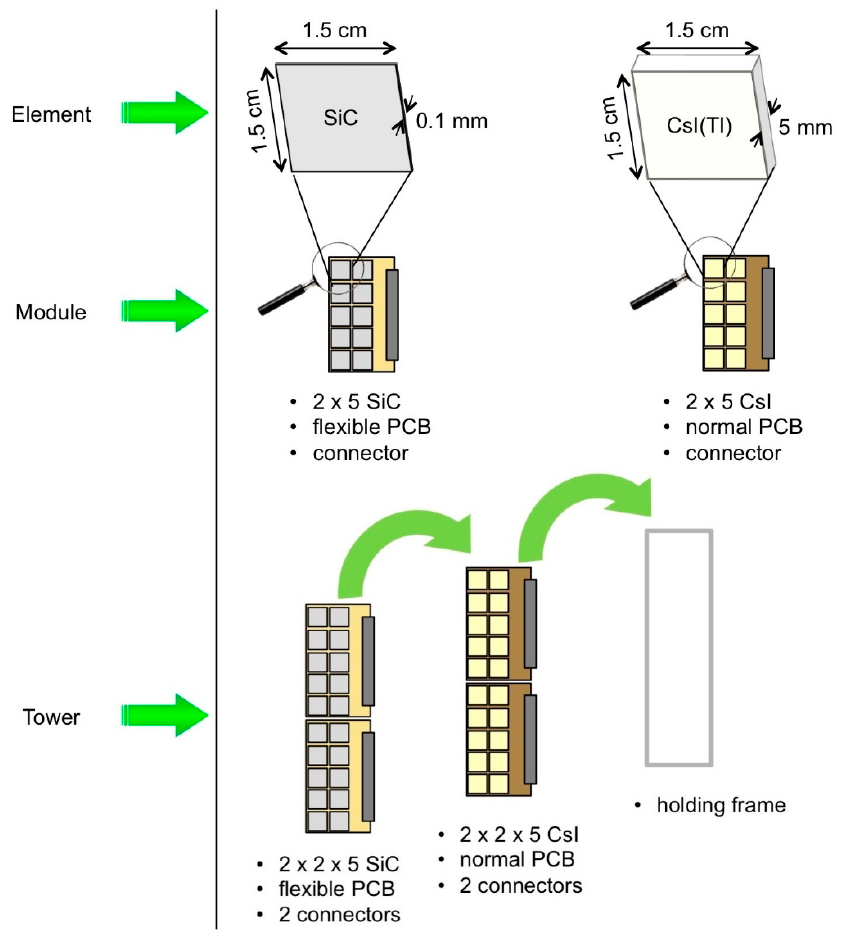
Figure 13. The modular structure of the Particle Identification Detector (PID): the elementary cells are arranged into independent modules , each one consisting of 10 telescopes ( elements ). The modules are arranged in groups of two into towers .